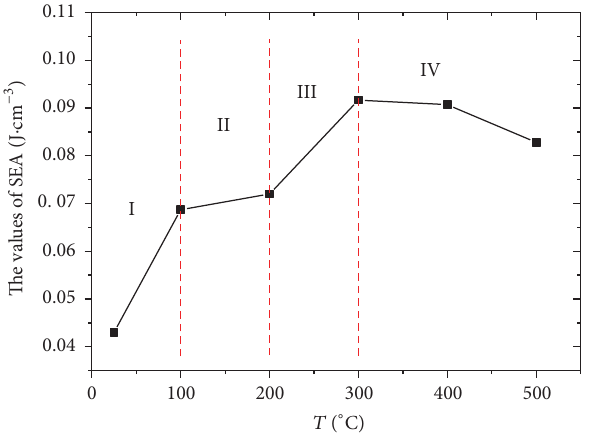
Figure 8: The relation between the values of SEA and